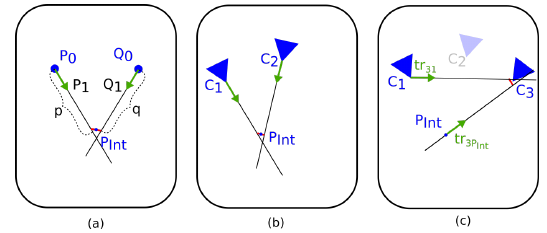
Figure 1. Computation of the perspective center of the ”third” im- age (C 3 ) in the Quick triplet algorithm . C 1 and C 2 are perspect- ive centers of images 1 and 2, respectively. Relative orientations between images 1 and 2 as well as 1 and 3 are known and related by a 7-parameter transformation. (a) A toy example illustrating −−−→ P 0 P 1 and the intersection of two straight lines defined by vectors −−−→ Q 0 Q 1 (cf. On straight lines intersection ); (b) intersection of two lines defined by their image observations and respective perspect- ive centers, C 1 and C 2 ; (c) the sought C 3 lies at the intersection of the vectors tr 31 and tr 3 P Int